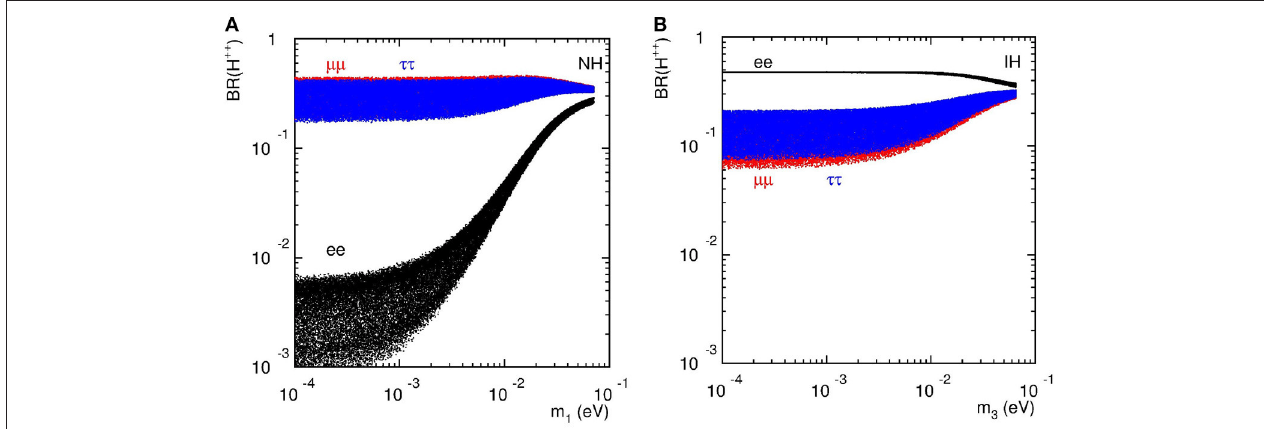
FIGURE 25 | Scatter plots for the H ++ decay branching fractions to the flavor-diagonal like-sign dileptons vs. the lowest neutrino mass for NH (A) and IH (B) with 8 1 8 2 0. = =